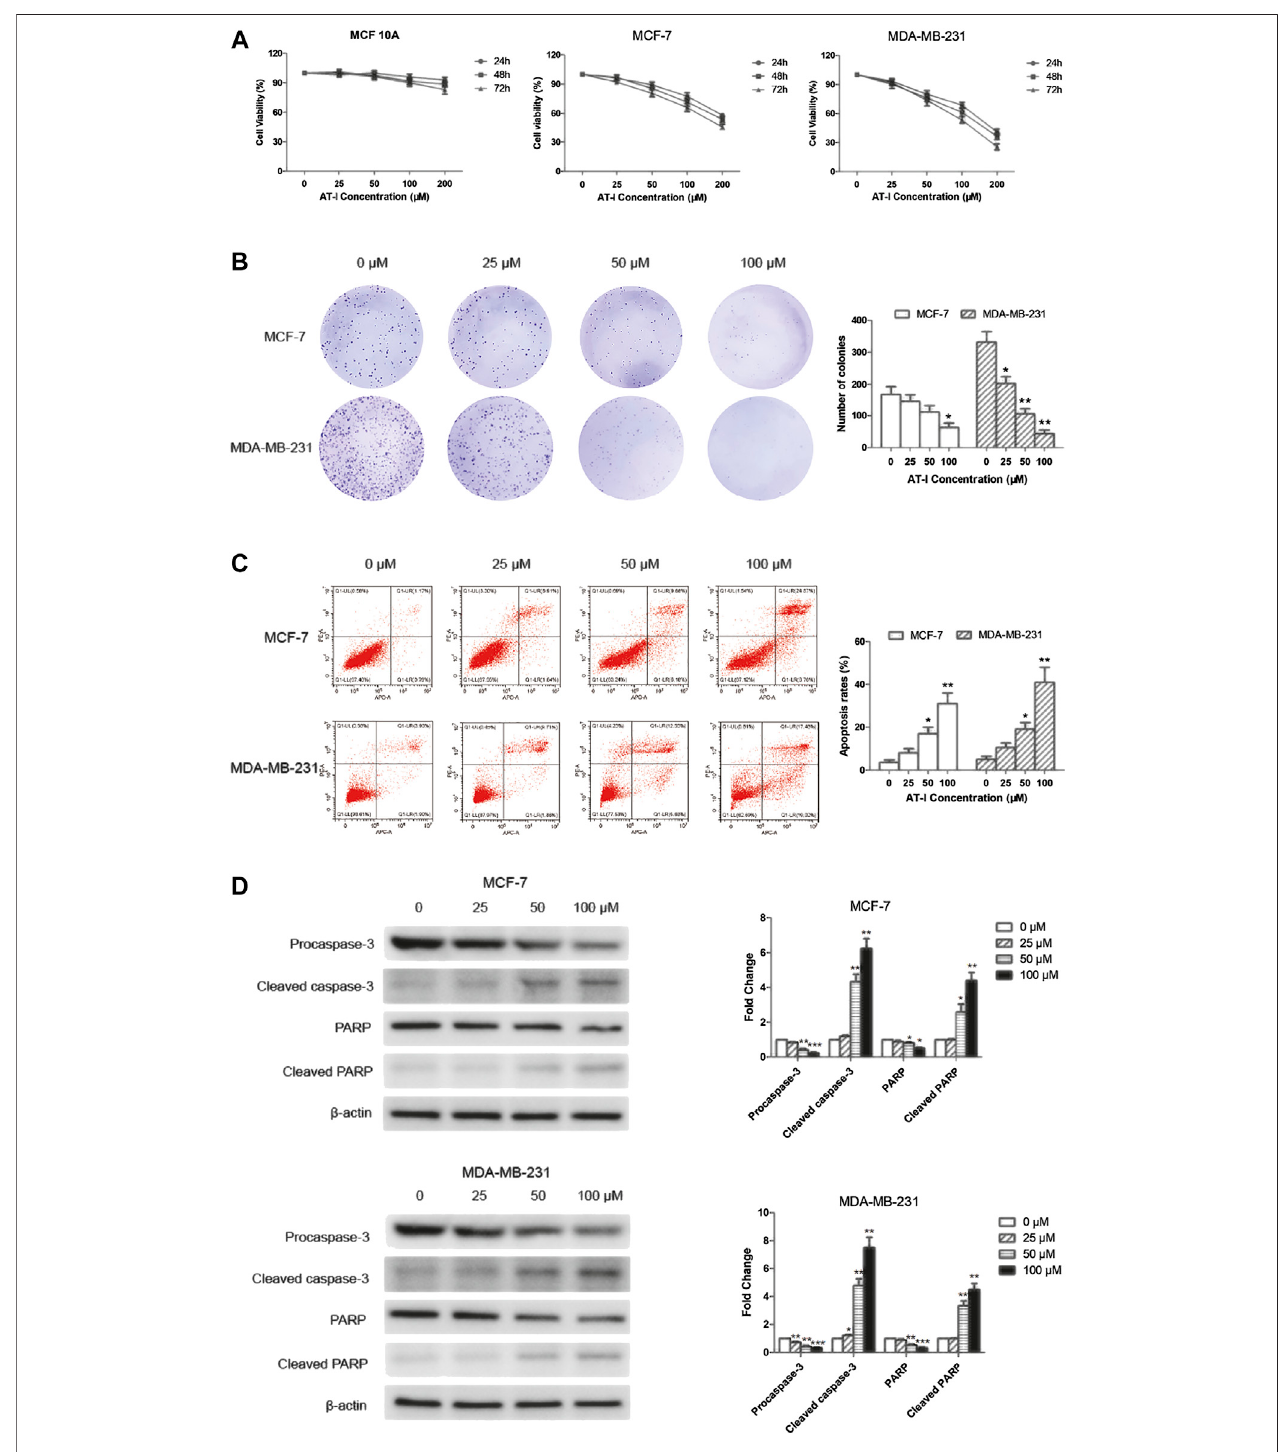
FIGURE 2 | AT-I inhibited cell growth and induced apoptosis in breast cancer cells. (A) MCF 10A, MCF-7 and MDA-MB-231 cells were treated with AT-I (0 – 200 µM) for 24, 48 and 72 h to determine cell viability. (B) MCF-7 and MDA-MB-231 cells were treated with AT-I (0 – 100 µM) for 48 h and then applied for colony formation.Thenumberofcolonieswascountedafter14 days. (C) MCF-7andMDA-MB-231cellsapoptosisassayaftertreatmentwithAT-I(0 – 100 µM)for48 h. (D) The effects of AT-I on the expression of procaspase-3, cleaved caspase-3, PARP and cleaved PARP were measured by western blot assay. Signi fi cant differences between different groups were indicated as * p < 0.05, ** p < 0.01, *** p < 0.001, vs. the 0 μ M control group, n (cid:1) 3.